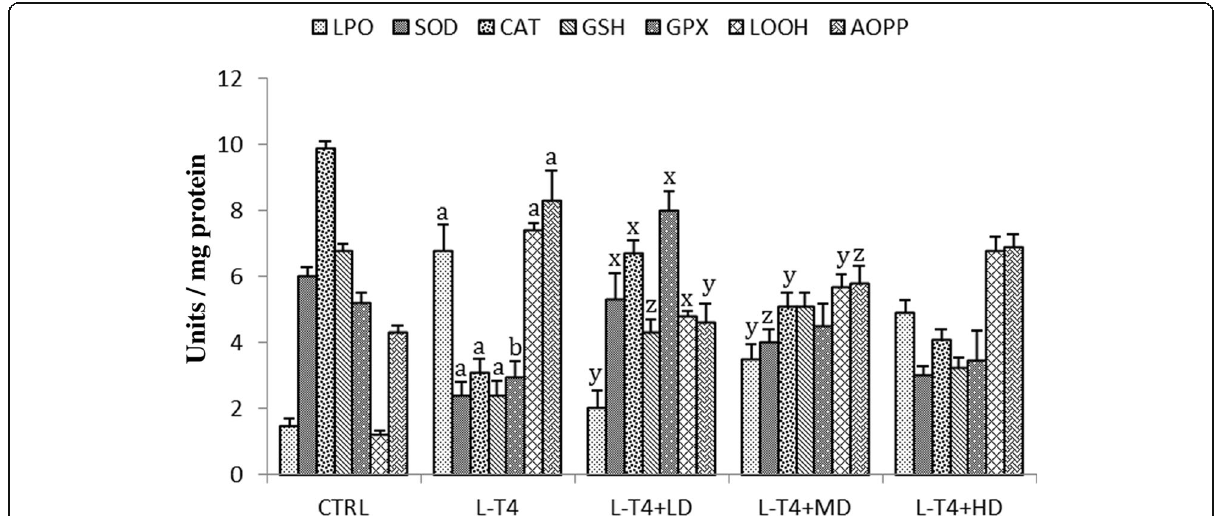
Fig. 3 Effects of ACC on the alterations in hepatic LPO (nm of MDA formed /h /mg protein), SOD (Units / mg protein, CAT ( μ M of H 2 O 2 decomposed per minute per mg protein), GPx ( μ moles of GSH oxidized/mg protein) and GSH ( μ M GSH per mg protein) in liver tissues. Each bar represents the mean±s.e.m., n=7. Ctrl, Control; T 3 , triidothyronine; T 4 , thyroxine. a P < 0.001 as compared to the respective control values. x P <0.001, y P <0.01 and z P <0.5 as compared to the respective values of L-T4 treated animals. GLU, glucose; CHOL, cholesterol; HDL, high density lipoprotein